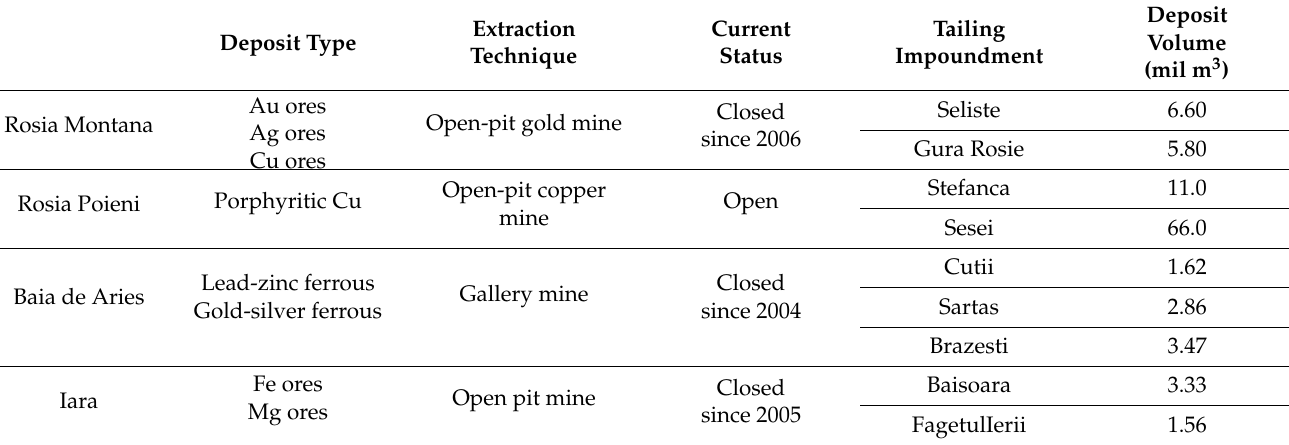
Table 1. Characteristics of the main tailing impoundments located in the Aries Rciver catchment [27].